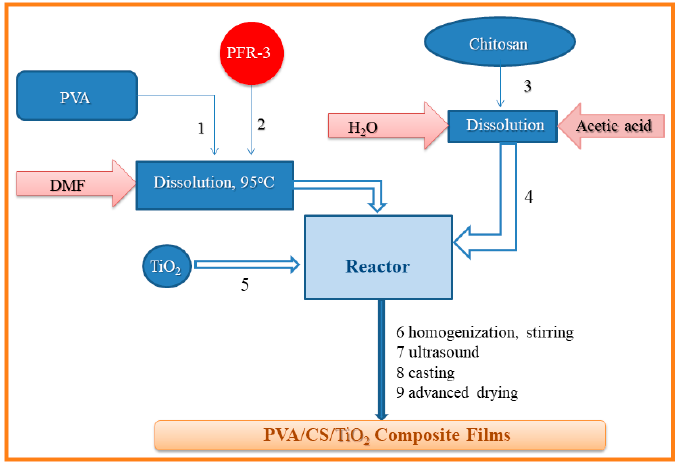
Figure 9. General scheme of the process for the preparation of films based on PVA and chitosan.